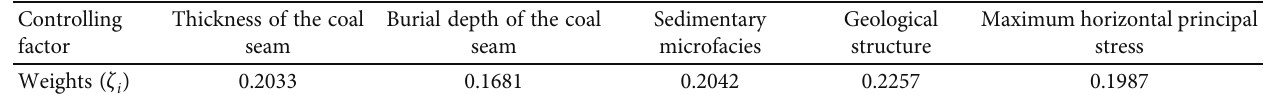
Table 3: Calculate the weight result by LS-FAHP-CRITIC